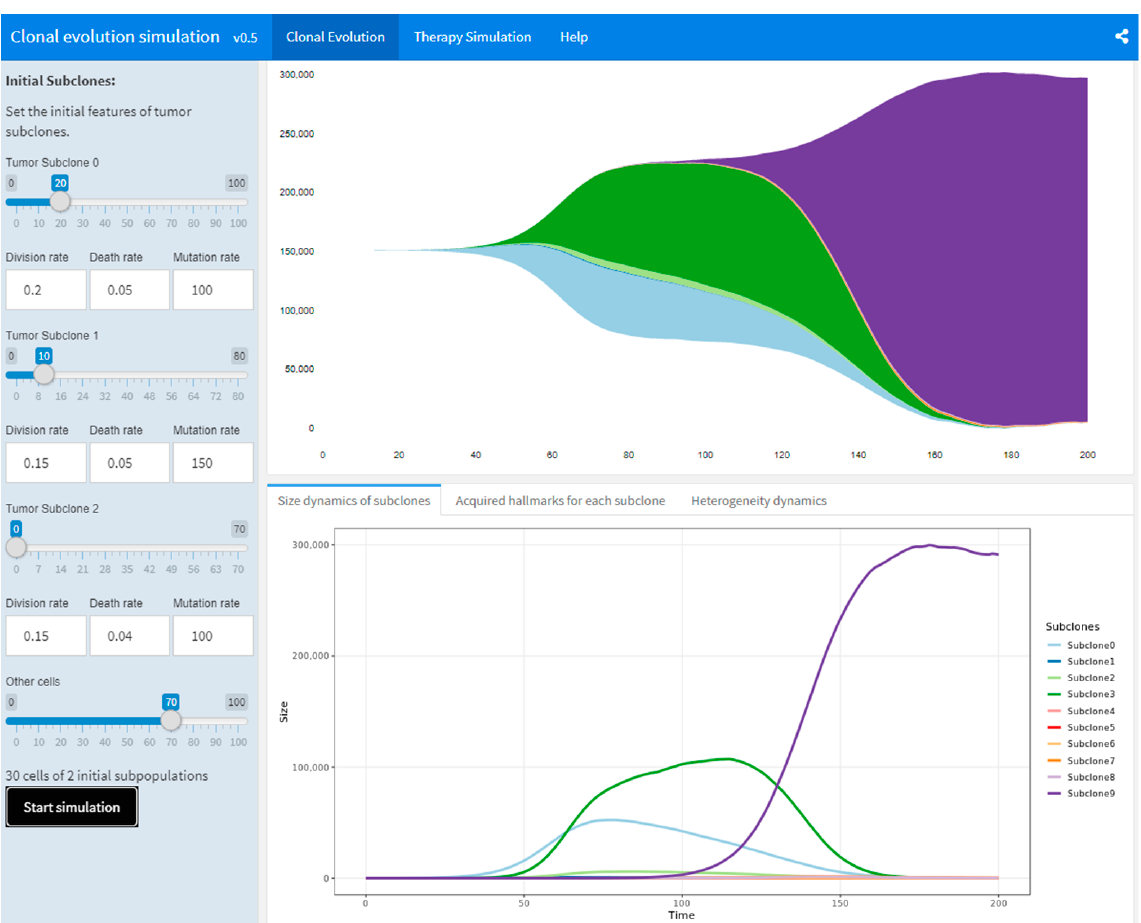
Figure 3. An online application for simulating the subclonal evolution of tumor cell populations. A screen-shot of the simulation output is shown. Initial values of the attributes for simulation are shown on the left panel. The streamplot indicates a dynamic progression of cell subpopulations. A mouse hovering over the main body shows the size of the corresponding subpopulation.